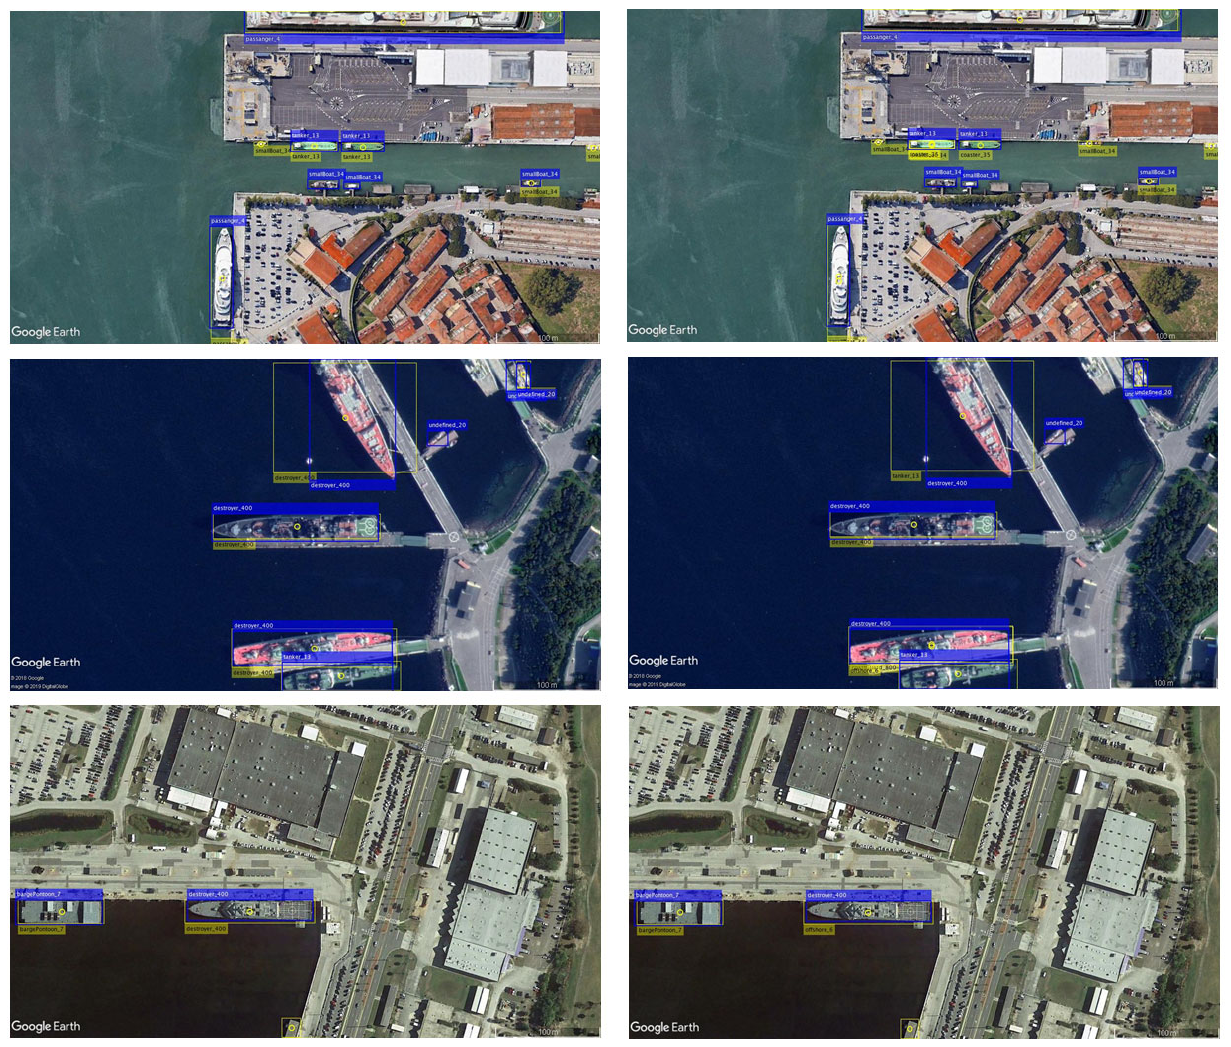
Figure 4. Comparative visuals of HieD (left column) and YOLOv4 (right column) for inshore regions (blue labels are the ground truth and yellow labels with a circle at the center of bBox are the results of HieD or YOLOv4).